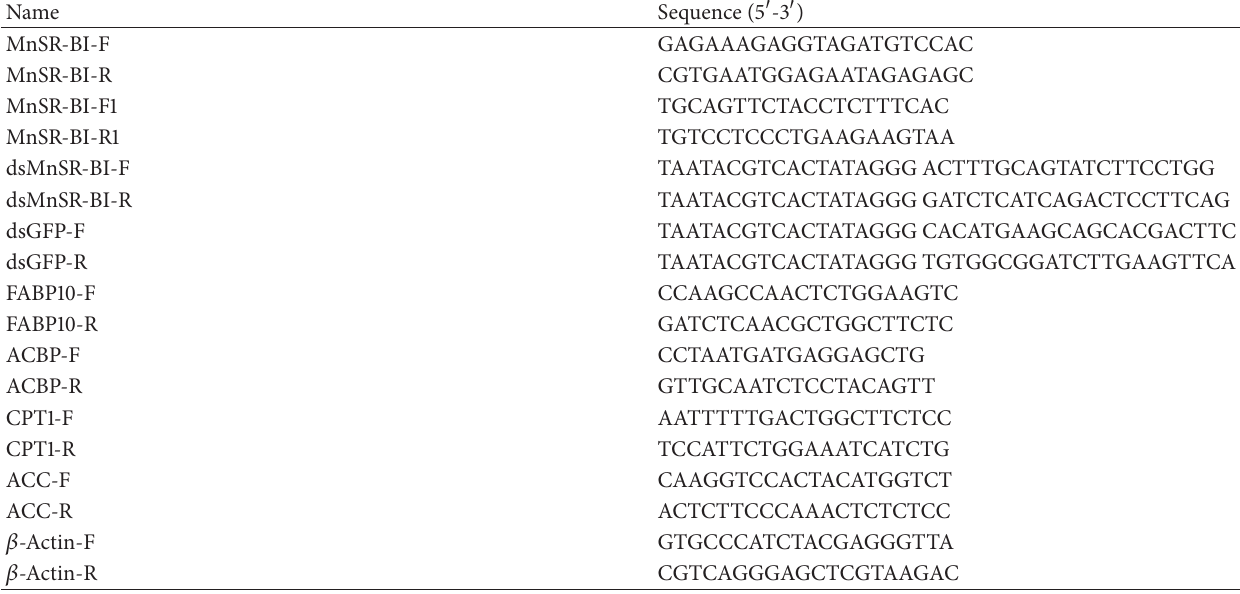
Table 3: Primers used in this